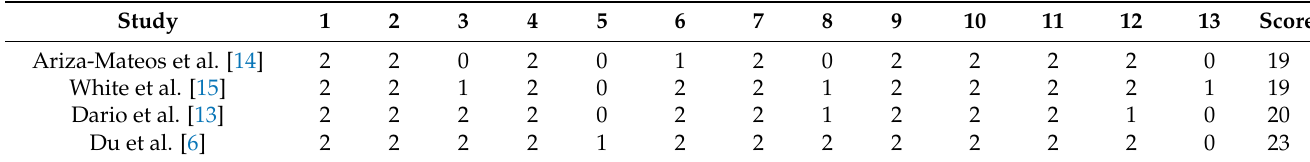
Table 3. Quality assessment scores.